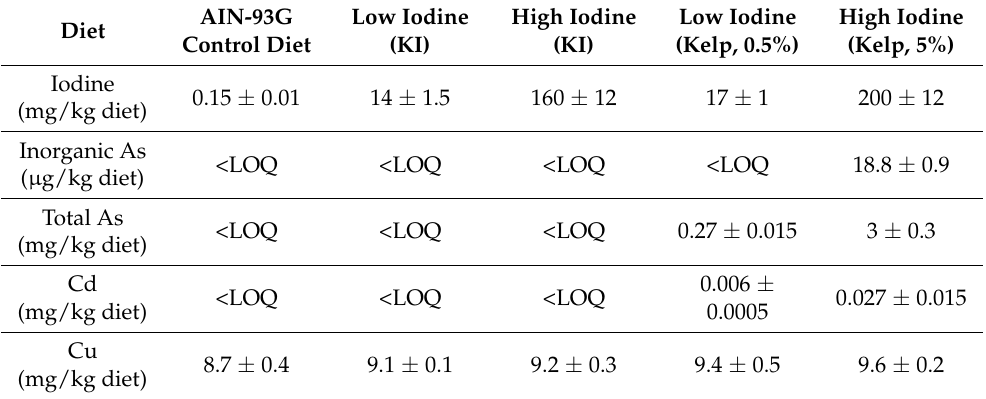
Table 1. Concentration of iodine, iAs, total As, Cd and Cu in the experimental diets. All diets were measured in duplicate, and the values are given as mean ±